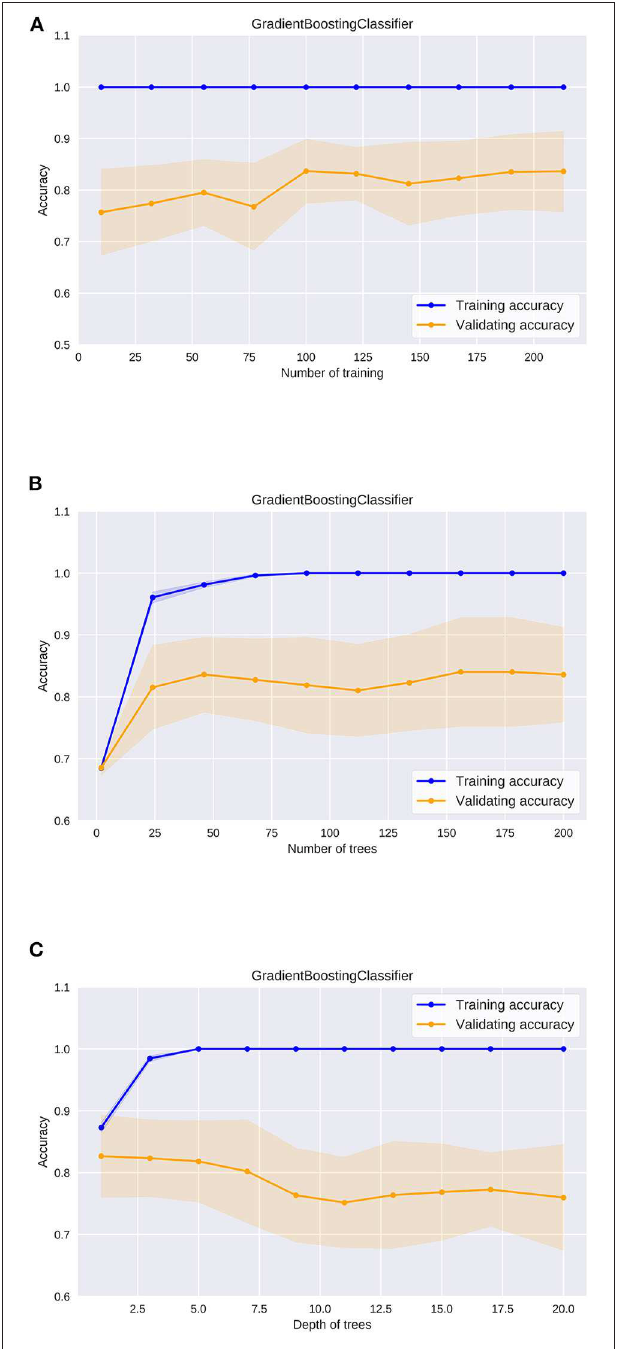
FIGURE 5 | The learning curve of the gradient boosting classifier (A) , the validation curve of the number of trees in the gradient boosting classifier (B) , the validation curve of the depth of trees in the gradient boosting classifier (C)